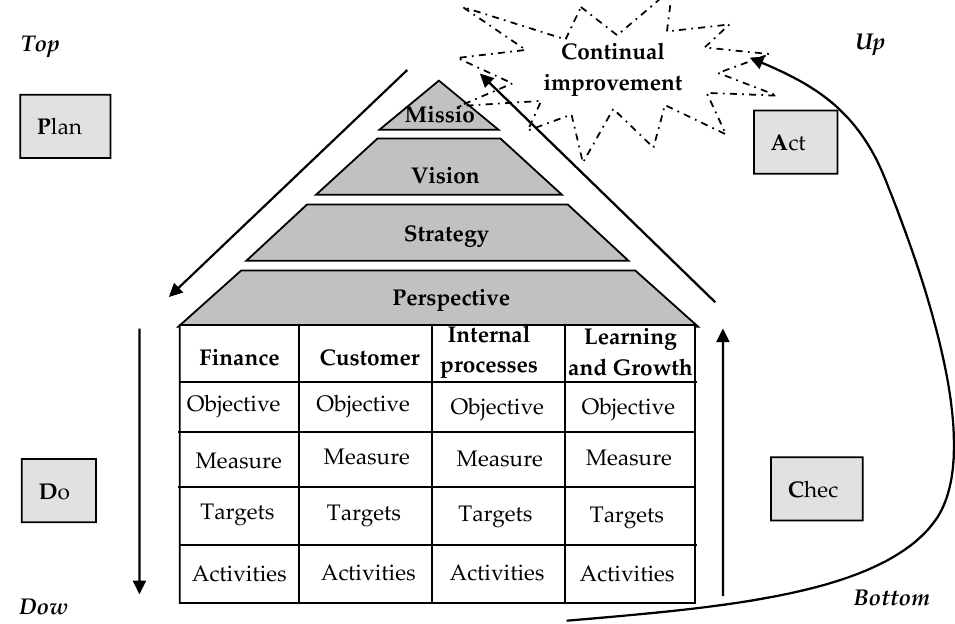
Figure 1. Managing mission, vision and strategy with the Balanced Scorecard (BSC) approach [17].